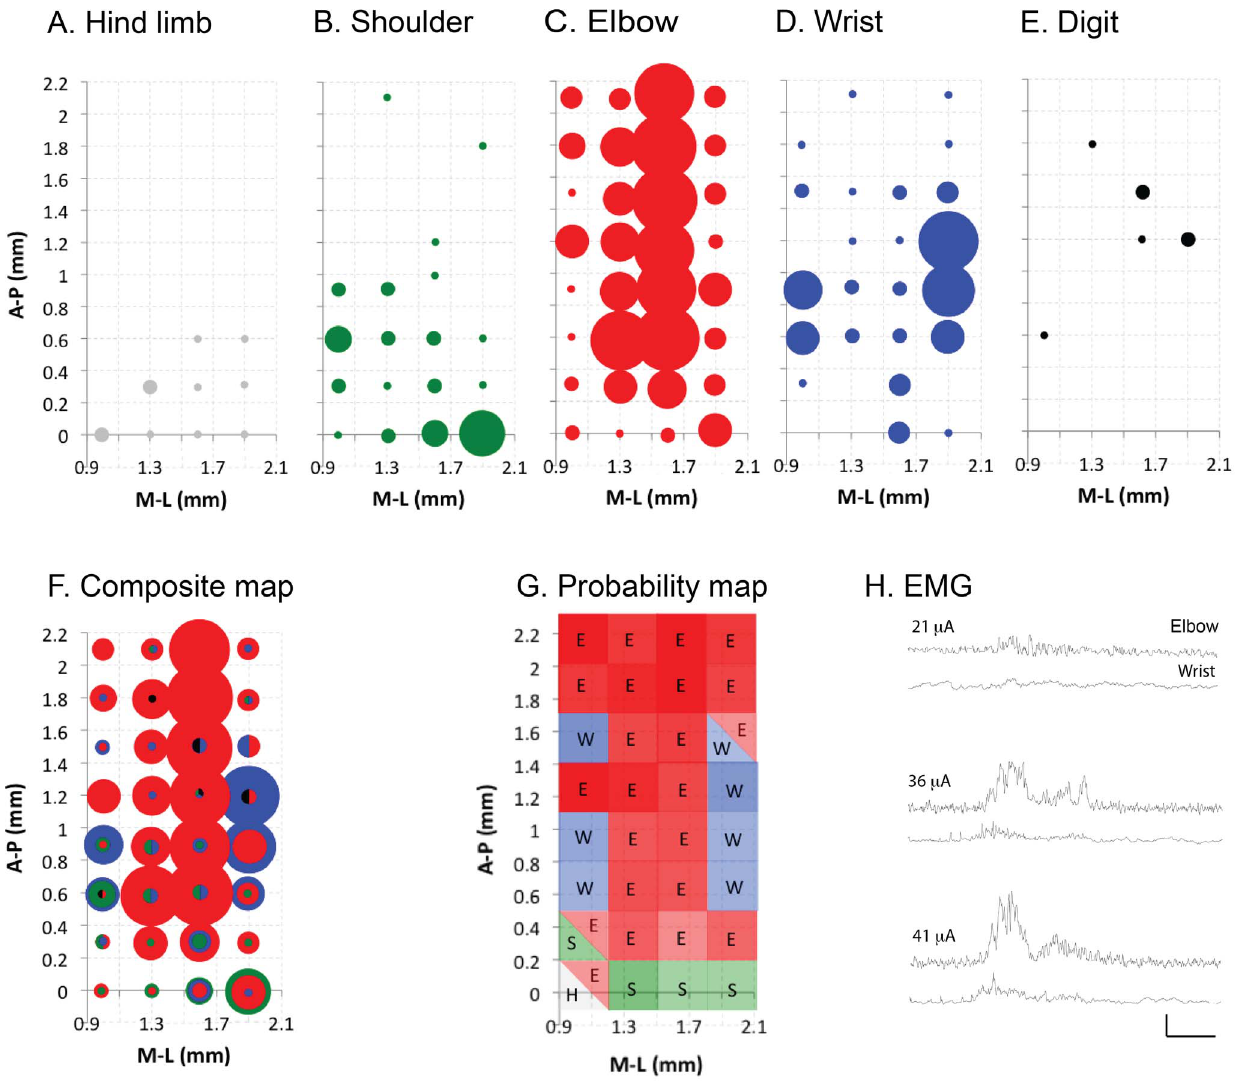
Figure 2. Joint-based organization of the forelimb region of the mouse motor cortex. Frequency distribution plots (A–E) show response topography. Axes show distances from bregma of the motor cortex area mapped. Medial-lateral (M–L) and anterior-posterior distances mapped were up to 1.9 and 2.1 mm respectively from bregma, which corresponds to most of the forelimb representation. Circle diameter for responses is directly proportional to response frequency across animals (10 responses maximum). (F) Representation maps were overlaid to determine any joint-bias within the cortical representation in the composite map. (G) The frequency plots were converted to an overall probability map based on the relative frequency of a dominant response at a specific site in relation to all responses at that site. Map shows the locations of dominant hind limb (H, grey), shoulder (S, green), elbow (E, red) and wrist (W, blue) responses. Shade intensity is directly proportional to the probability of provoking a response for a particular joint. (H) Representative EMG data from contralateral forelimb muscles in response to: threshold cortical stimulation for evoking an elbow response (21 m A, top traces); threshold cortical stimulation for evoking a wrist response (36 mA suprathreshold cortical stimulation for evoking both elbow and shoulder responses (41 m A, bottom traces). Vertical and horizontal scales are 0.5 V and 20 ms